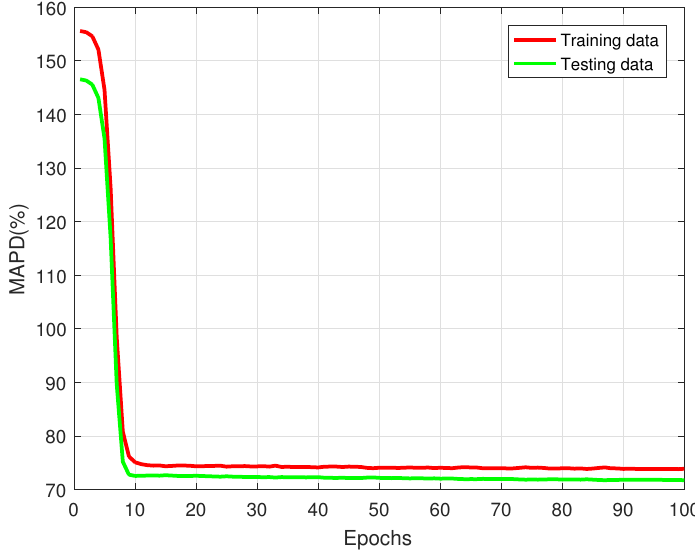
Figure 7. Learning evaluation of deep learning FCRBM model on testing and training datasets in terms